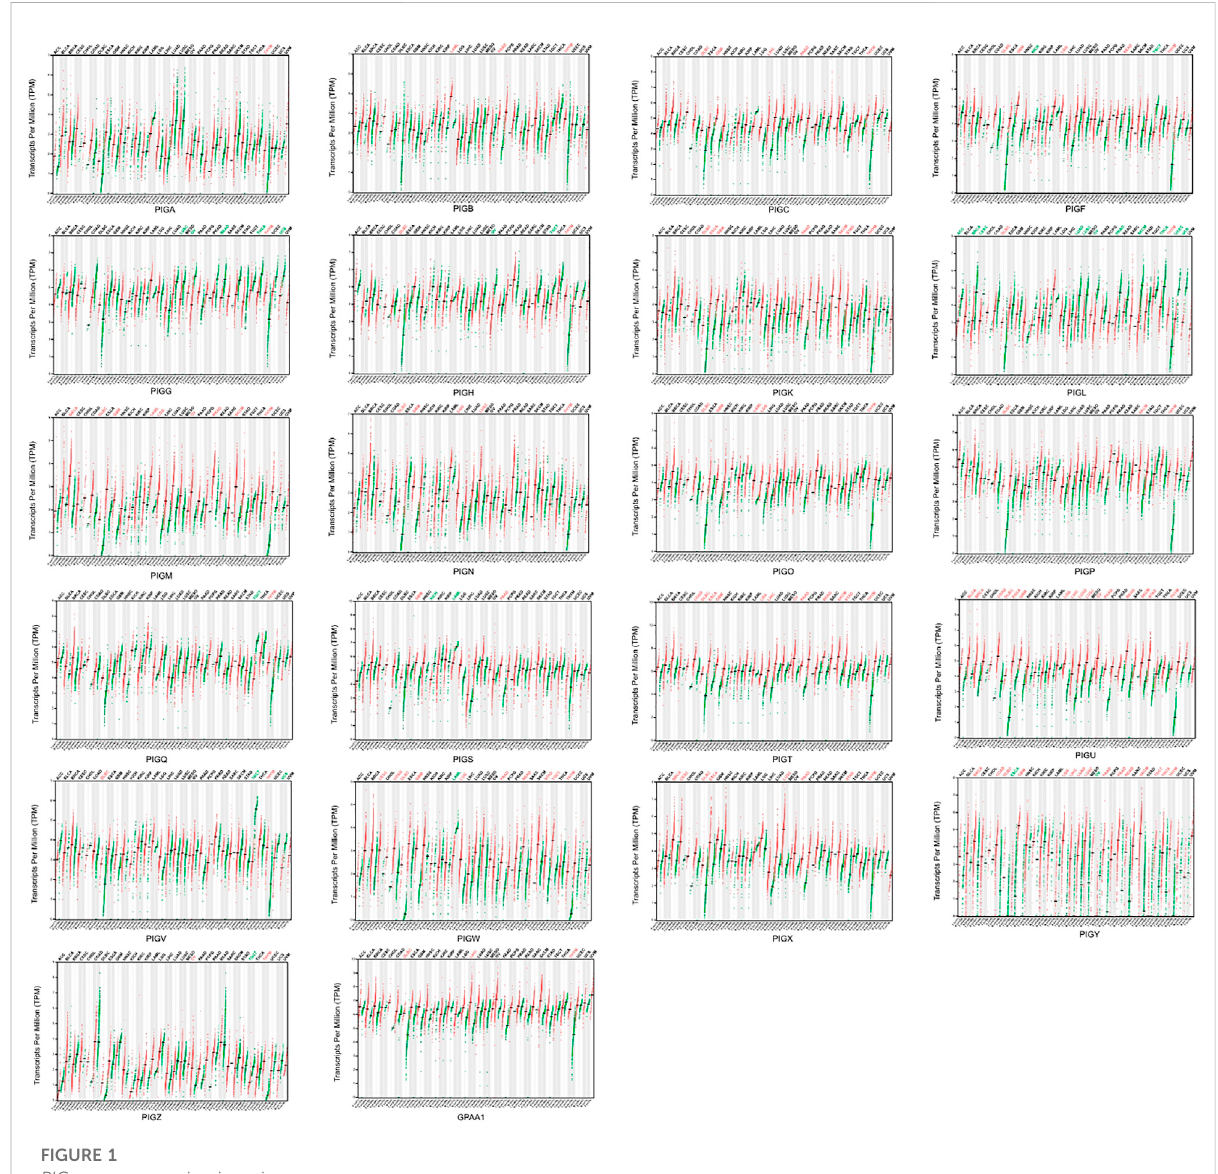
FIGURE 1 PIG genes expression in various